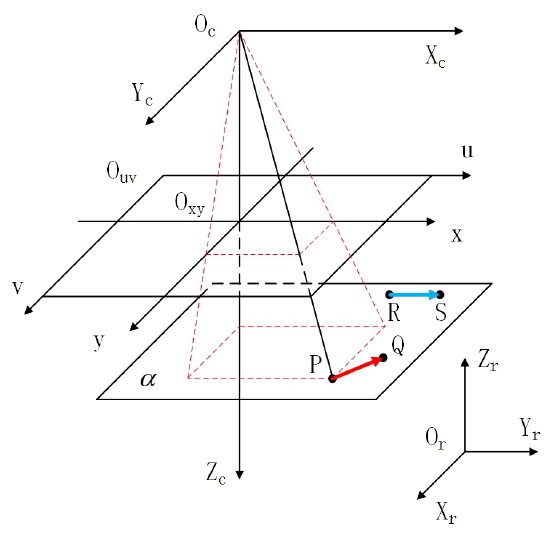
Figure 11. Geometry of the ideal camera